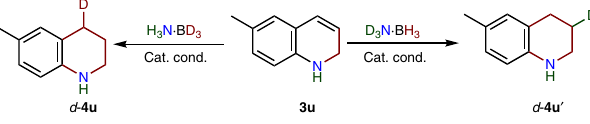
Fig. 9 Deuterium labeling. Reductions of 3u with deuterated ammonia borane